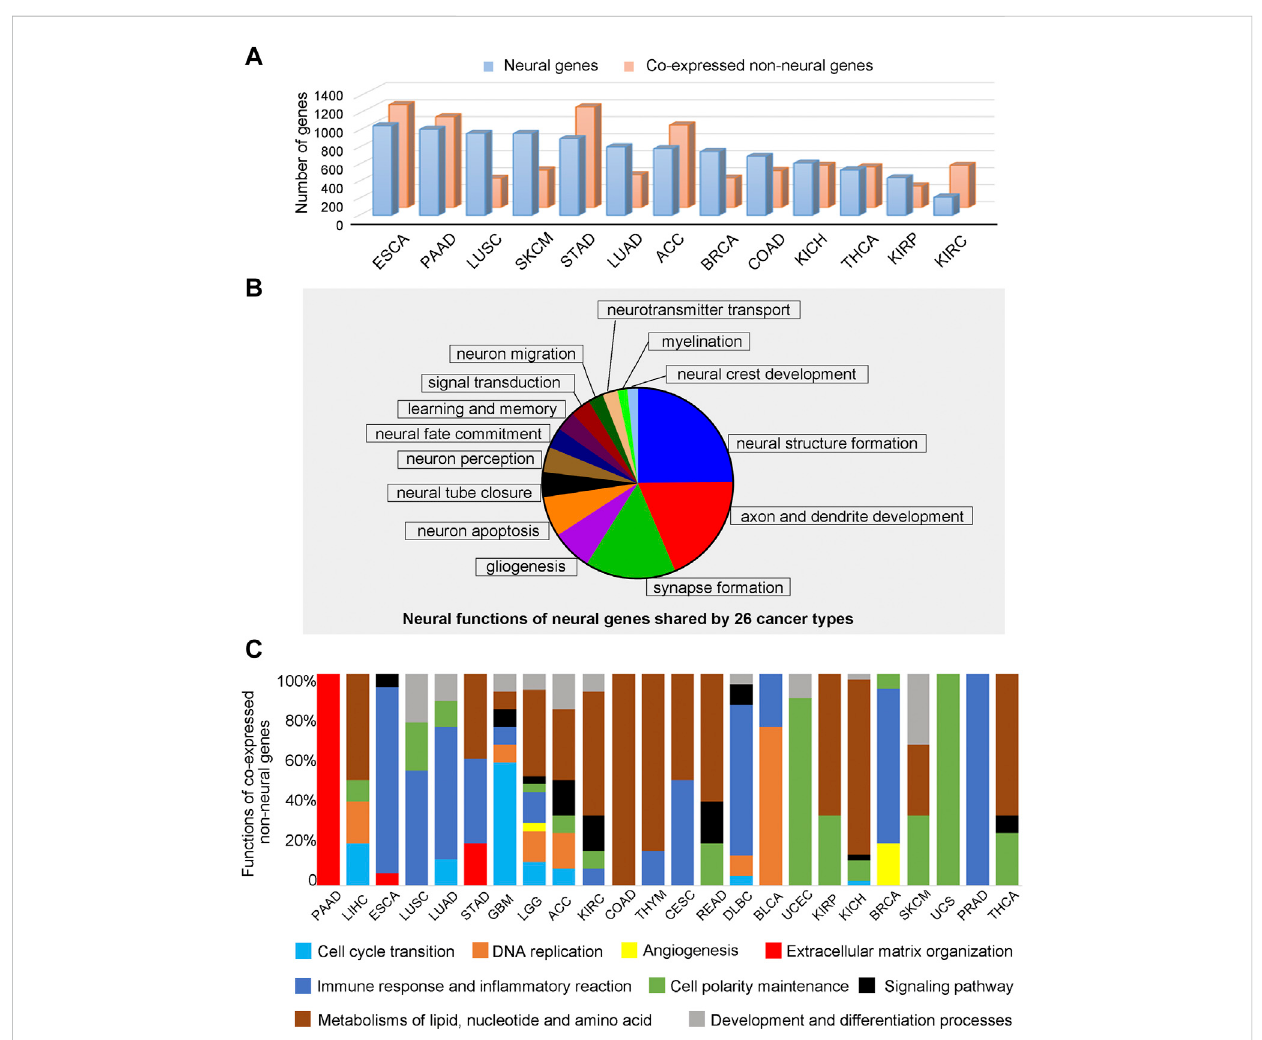
FIGURE 4 Function analyses of neural genes and co-expressed non-neural genes across 26 cancer types. (A) The number of co-expressed neural and non- neuralgene pairsacrossdifferentcancertypes. (B) Functions ofexpressed neuralgenes sharedby26cancertypes. (C) Proportionsofpathways enriched by co-expressed non-neural genes in TME across different cancer types. Blue is for cell-cycle transition related pathways, orange for DNA replication related pathways, yellow for angiogenesis related pathways, red for extracellular matrix organization related pathways, dark blue for immune response and in fl ammatory reaction related pathways, green for cell polarity maintenance related pathways, black for signaling pathway related pathways, brownfor metabolisms oflipid,nucleotide and aminoacid relatedpathways,and grayisfor developmentand